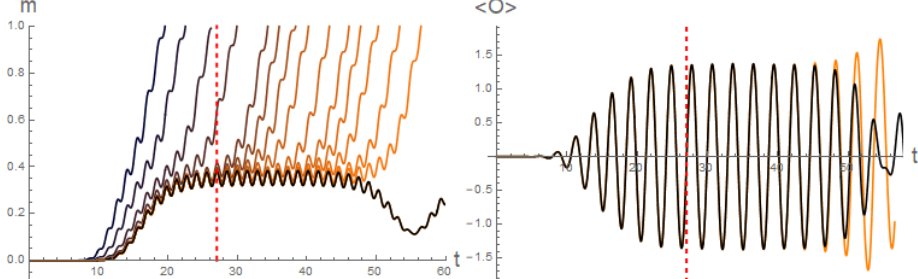
Figure 35 . Left: energy density for a family of build-up processes of the harmonic driving ! b = 2 : 15, (cid:15) = 0 : 09. The (cid:12) of the last build-up process ending in the runaway phase has been marked by the vertical dashed red line. Right: hOi for the last simulation ending in the runaway phase (solid orange) and the (cid:12)rst one ending in the non-collapsing phase (solid black).